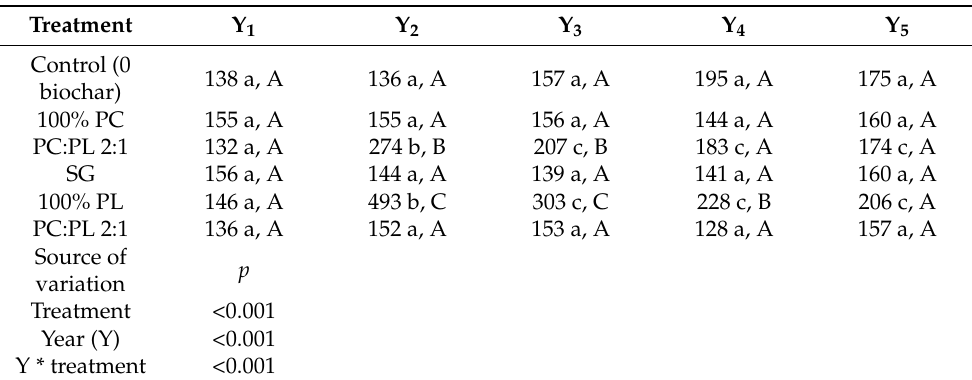
Table 5. Topsoil (0–15 cm deep) Mehlich 1 extractable soil potassium (K) concentrations in kg ha − 1 by treatment and year (means from n = 4; Y = year; PC = pine chip biochar; PL = poultry litter biochar; SG = switchgrass compost).